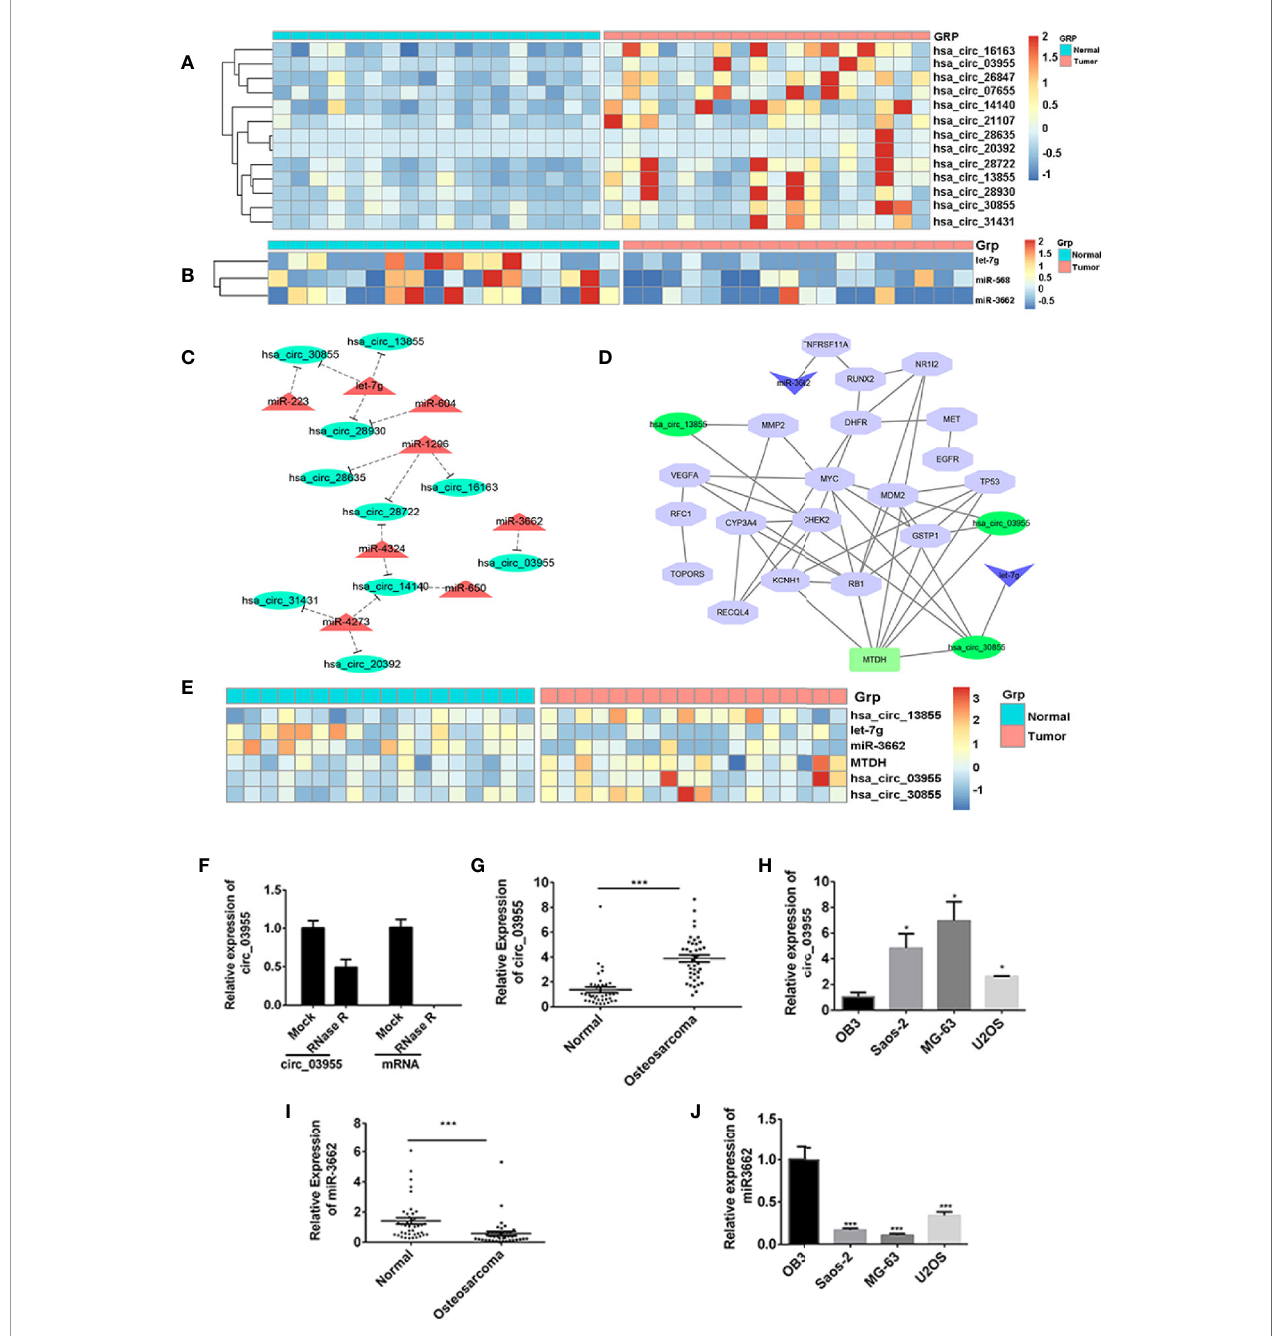
FIGURE 1 | circ-03955 was markedly increased in osteosarcoma cells and tissues. (A) Thermal map of circRNAs that are differentially expressed in the GSE99671 data set. (B) Thermal map of the miRNAs that regulate MTDH expression and are differentially downregulated in the GSE99671 data set. (C) Network map constructed using the GSE99671 data set showing signi fi cantly upregulated circRNA-bound miRNAs and downregulated miRNAs. (D) The fi rst 20 genes associated with osteosarcoma were screened by the DisGeNET database for co-expression analysis with ceRNA network maps. (E) Thermograph of gene expression in the ceRNA network of Fig 1D, which was analyzed using GSE99671. (F) The expression of circ-03955 and mRNA detected by qRT-PCR in MG-63 cells treated with RNase R. (G) The expression of circ-03955 detected by qRT-PCR in 40 samples of osteosarcoma tissue specimens and 40 samples of adjacent non-osteosarcoma tissue specimens. (H) Expression of circ-03955 detected by qRT-PCR in normal osteoblasts OB3 in three osteosarcoma cell lines: Saos-2, MG-63, and U2OS. (I) The expression of miR-3662 detected by qRT-PCR in 40 samples of osteosarcoma tissue specimens and 40 samples of adjacent non-osteosarcoma tissue specimens. (J) Expression of miR-3662 detected by qRT-PCR in normal osteoblasts OB3 and three osteosarcoma cell lines: Saos-2, MG-63, and U2OS. Data are presented as the mean ± standard deviation of three independent experiments, * p < 0.05, *** p < 0.001 vs. normal group or OB3